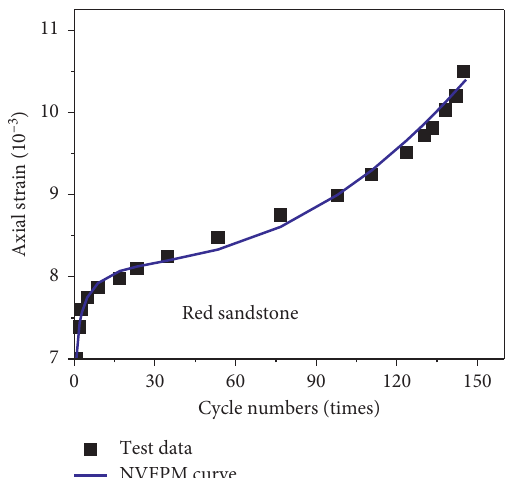
Figure 11: Fatigue deformation of red sandstone [51] fitted by the NVPFM.